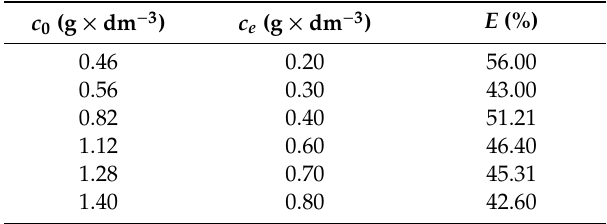
Table 2. Equilibrium concentrations of Fe 3 + in solutions and adsorbed amounts relative to di ff erent initial concentrations.